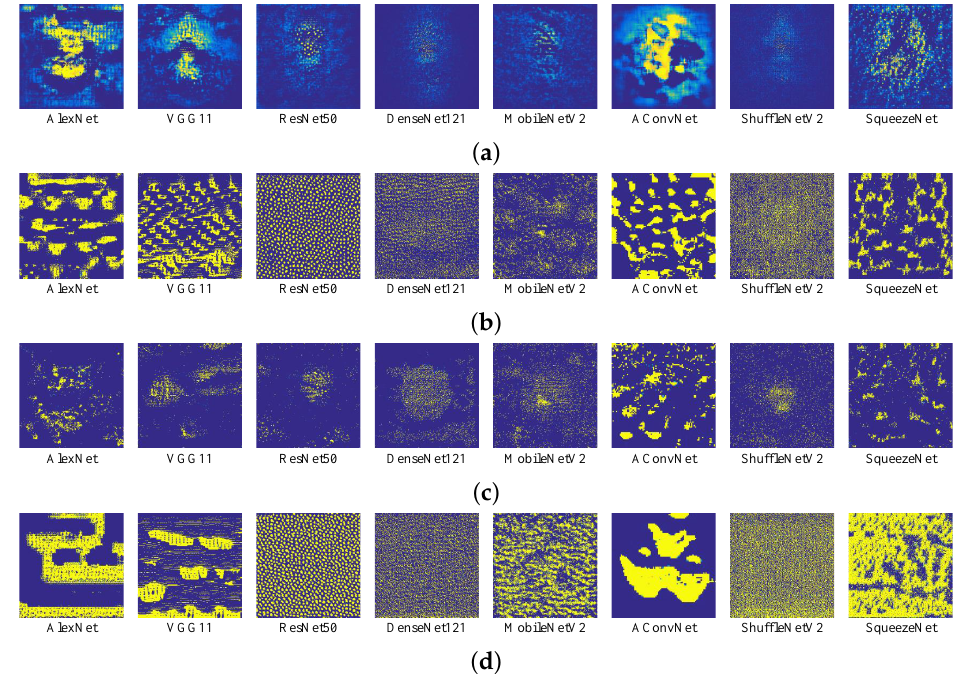
Figure 5. UAPs generated by different algorithms for the studied DNN models: ( a ) DeepFool-UAP; ( b ) DF-UAP; ( c ) CosSim-UAP; and ( d ) GD-UAP. All the UAPs are enlarged to [ − 1,1 ] for